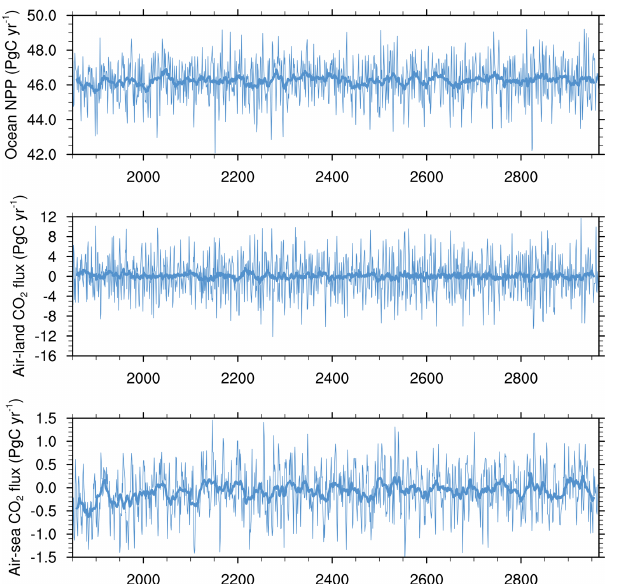
Figure A1. Time series of model simulations of ocean net primary production, air–sea CO 2 flux, and air–land CO 2 flux in the pre- industrial control run. The thin lines are annual mean time series, and the thick lines are their 20-year running